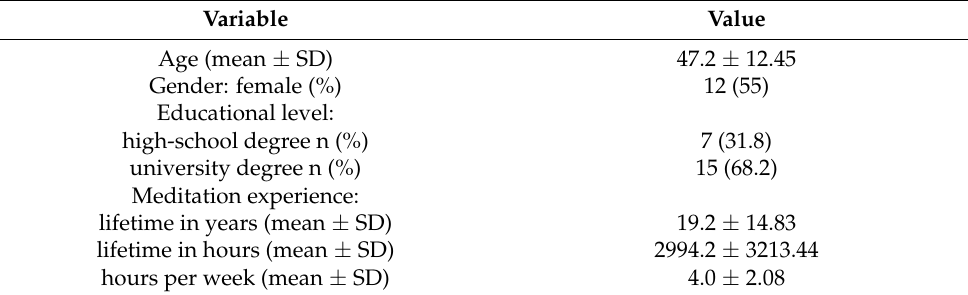
Table 1. Descriptive statistics of the study group (n =